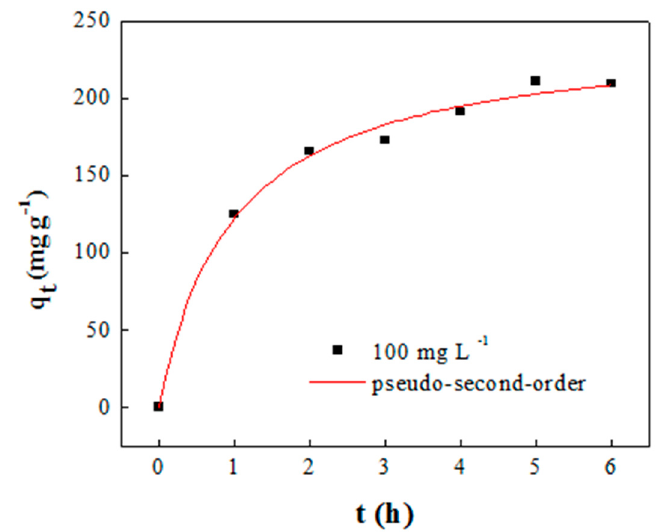
Figure 5. Adsorption kinetic of methylene blue onto T-MX (expressed as the adsorption capacity q t vs Figure 5 . Adsorption kinetic of methylene blue onto T ‐ MX (expressed as the adsorption capacity q t vs contact time t) and best-fitting by the pseudo-second-order model (10 mg T-MX, pH 7, 150 rpm, 20 ◦ C). contact time t) and best ‐ fitting by the pseudo ‐ second ‐ order model (10 mg T ‐ MX, pH 7, 150 rpm, 20 °C).